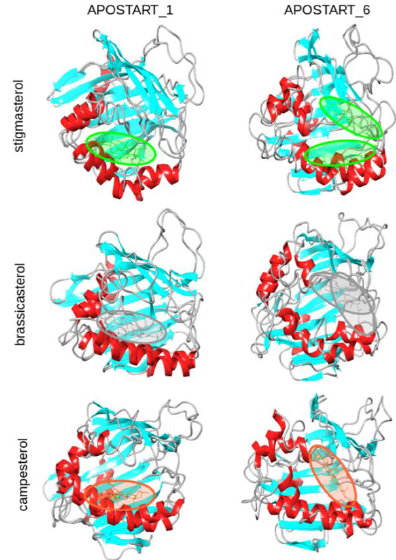
Figure 7. Representation of the binding complexes of APOSTART_1 and APOSTART_6 (cartoon) with the considered phytosterols (sticks). Binding sites of stigmasterol (green), brassicasterol (gray), and campesterol (orange) at the two proteins are also displayed.